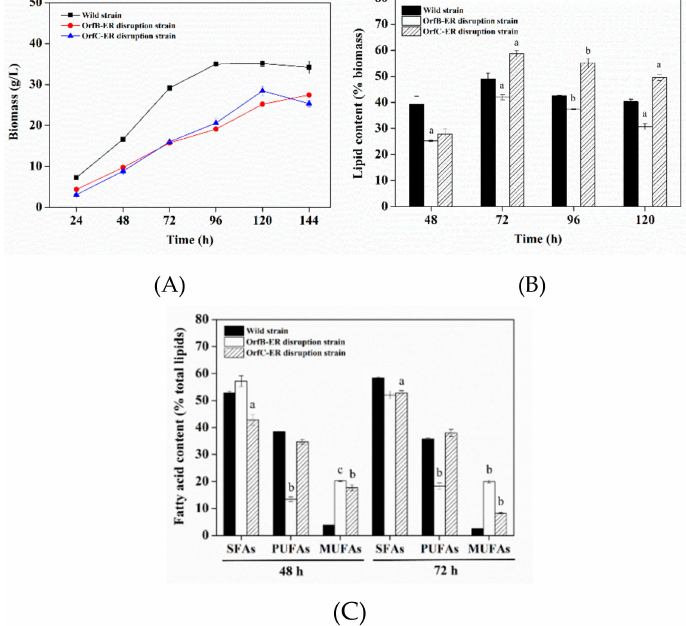
Figure 3. ( A ) Biomass, ( B ) lipid content of the biomass, and ( C ) fatty acid content of total lipid in the wild-type strain, OrfB-ER disruption strain, and OrfC-ER disruption strain. Significant di ff erence between wild type strain and disruption strain is indicated at p < 0.05 (a), p < 0.01 (b), or p < 0.001 (c) level. All data are expressed as mean ± S.D. of three independent